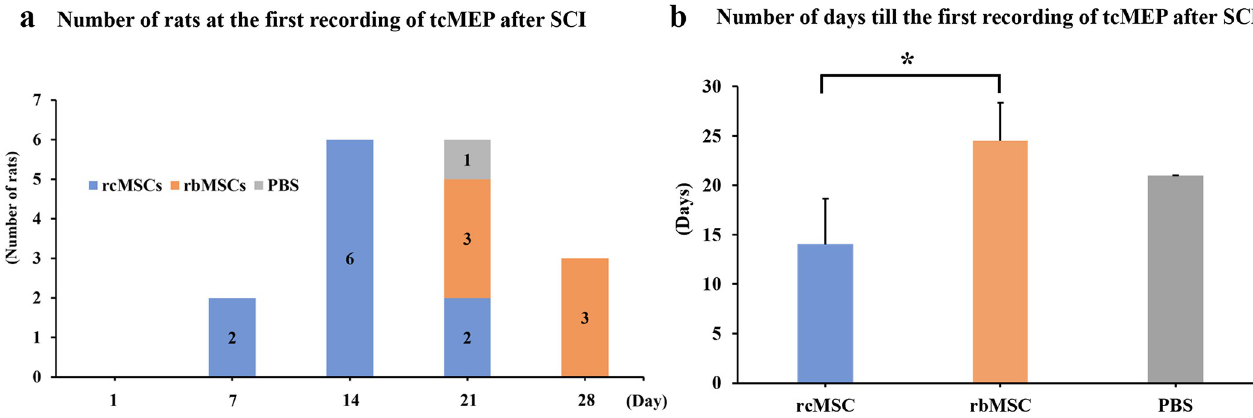
Fig 5. Relationship between the time course of recovery from paralysis and reappearance of the transcranial electrically stimulated motor-evoked potential (tcMEP) waveform. a. Number of rats at the first recording of tcMEP after spinal cord injury (SCI). Reappearance of tcMEPs was confirmed in 17 rats. In two, six, and two rats on days 7, 14, and 21, respectively, the first recorded tcMEPs after SCI were confirmed in the rat cranial bonel-derived mesenchymal stem cell (rcMSC) group. In three rats on days 21 and 28, the first recorded tcMEPs after SCI were confirmed in the rat bone marrow-derived mesenchymal stem cell (rbMSC) group. In the PBS group, the tcMEP reappeared in only one rat on day 21 after SCI. b. Number of days till the first recording of tcMEP after SCI. Data are presented as mean ± standard deviation; n = 10, 6, and 1 for rcMSC, rbMSC, and PBS groups, respectively. � P < 0.05, rcMSC group vs. rbMSC